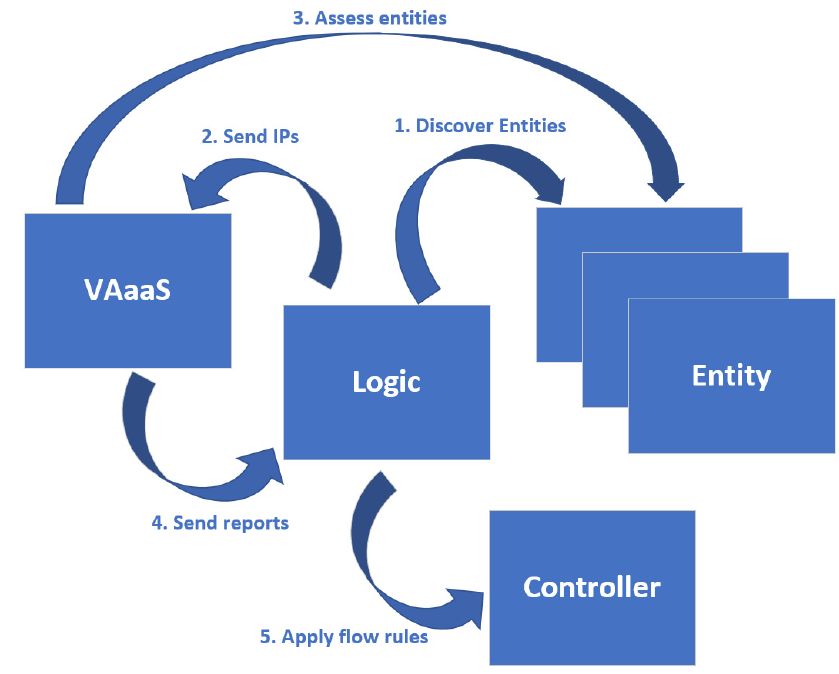
Figure 2. Identification use case conceptual diagram.